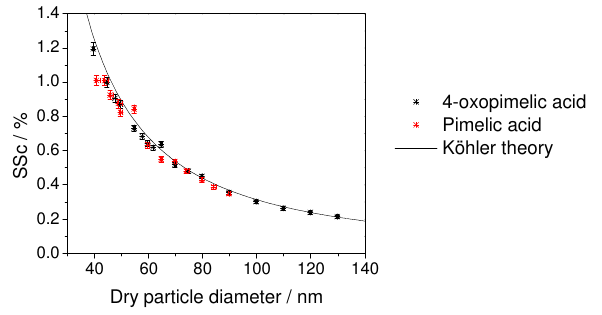
Fig. 14. The critical supersaturation of pimelic acid and 4- oxopimelic acid as a function of dry particle diameter. The exper- imental data are compared to a K¨ohler curve (surface tension of water, no dissociation).